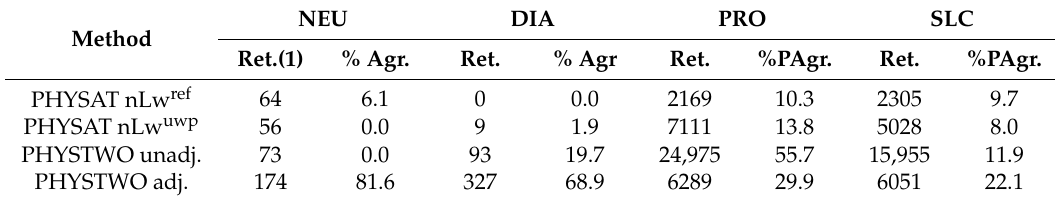
Table 3. The comparison between PFT retrievals with in situ and published data. Ret = the total number of retrievals on PHYTOFRONT transects. % Agr. = The percentage of retrievals on PHYTOFRONT transects that are in agreement with the in situ dominance of Diatoms and Nanoeukaryotes measured in the FluoroProbe profiles. % PAgr. = the percentage of retrievals that are in agreement with the areas of likely dominance by Prochlorococcus (where Chl-a concentration is <0.35 mg · m − 3 ) and Synechococcus (where Chl-a is between 0.26 and 0.5 mg · m − 3